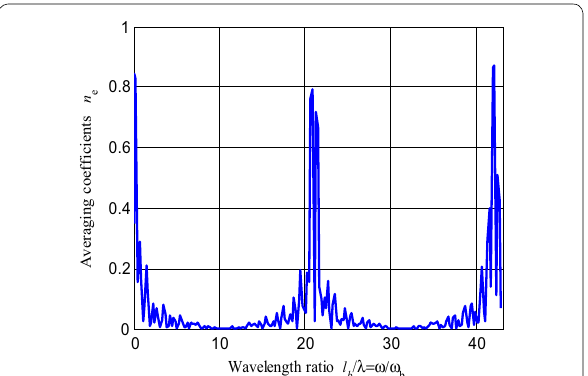
Figure 10 Averaging coefficient curves for different high-frequency 3 Factors Affecting Error Averaging The guideway straightness errors are decomposed into components with different wavelengths. Assuming that the form of each error component is such that e ( z ) = A cos((2π/ λ ) z ), then the table kinematic errors ( δ x ( z ), δ y ( z ), ε x ( z ), ε y ( z ), and ε z ( z )) caused by different compo- nents are calculated by way of Eq. (28). n e is defined as the ratio of the kinematic error to the guideway error, as the averaging coefficient to characterize the error averag- ing effect of the rolling guide pair: δ y (ω) = . (29) n e e (ω) Eq. (29) is used to analyze the factors affecting the table linearity error δ y ( ω ). Analyses of other table kin- ematic errors are based on their respective averaging coefficients. (1) Wavelength The influence of the guideway error wavelength on the error averaging effect of the rolling guide pair is analyzed when each error component has the same amplitude and phase. Defining the wavelength ratio as the ratio of the carriage length l b to the guideway error wavelength λ , as ω b 2π/ l b and ω 2π/ λ , this = = wavelength ratio l b / λ is equal to the ratio ω/ω b . exerts a significant influence on the error averaging, but when the wavelength ratio l b / λ 0, 21, 42, …, = the averaging coefficient n e is very large (Figure 7). ers, τD a , is integral multiple of the guideway error wavelength λ under these wavelength ratios, and that cannot be offset.